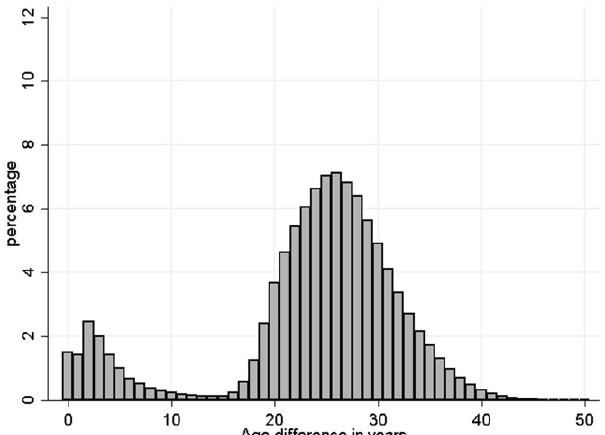
Fig. 2 Distribution of age differences of matches, female/female. (Note: Includes all female-female pairs of individuals who we were able to match by location and name (according to our name-matching algorithm). Age difference is calculated as older age – younger age)